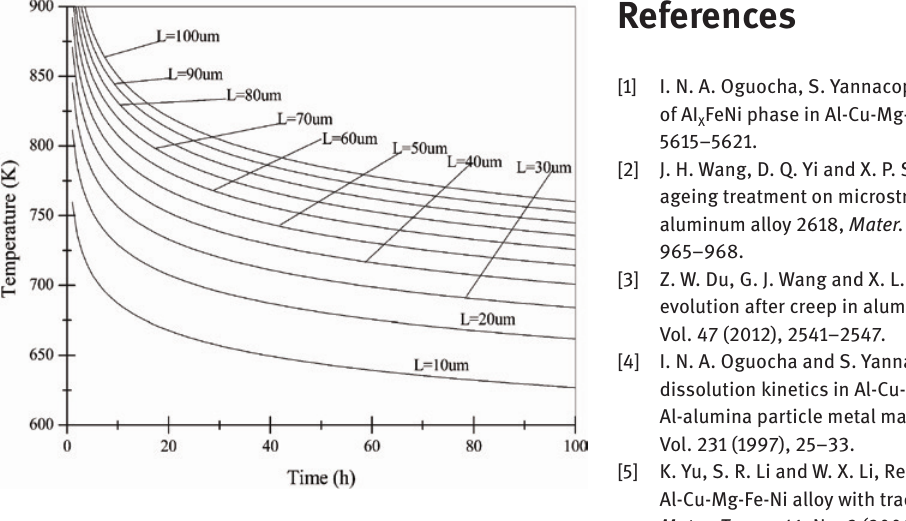
Fig. 8: Relationship between homogenization temperature and time at different interdendritic